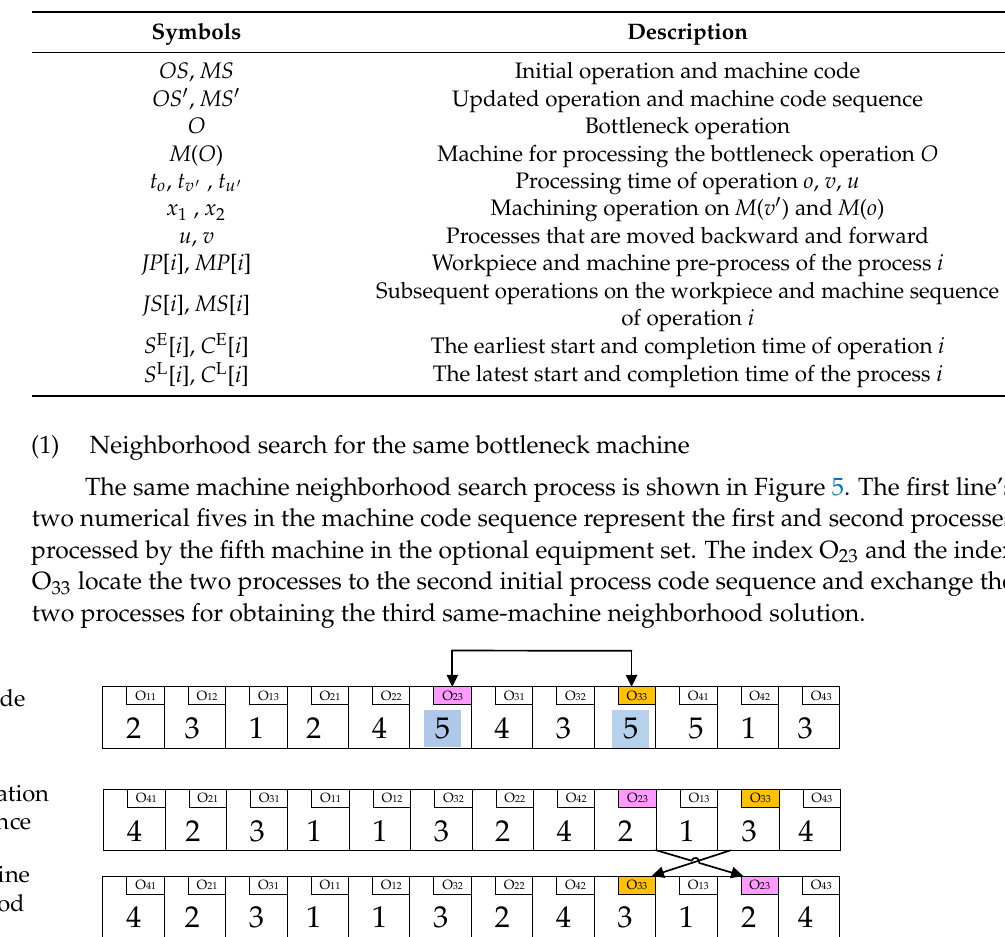
Table 2. Symbols in neighborhood structure and their interpretations.